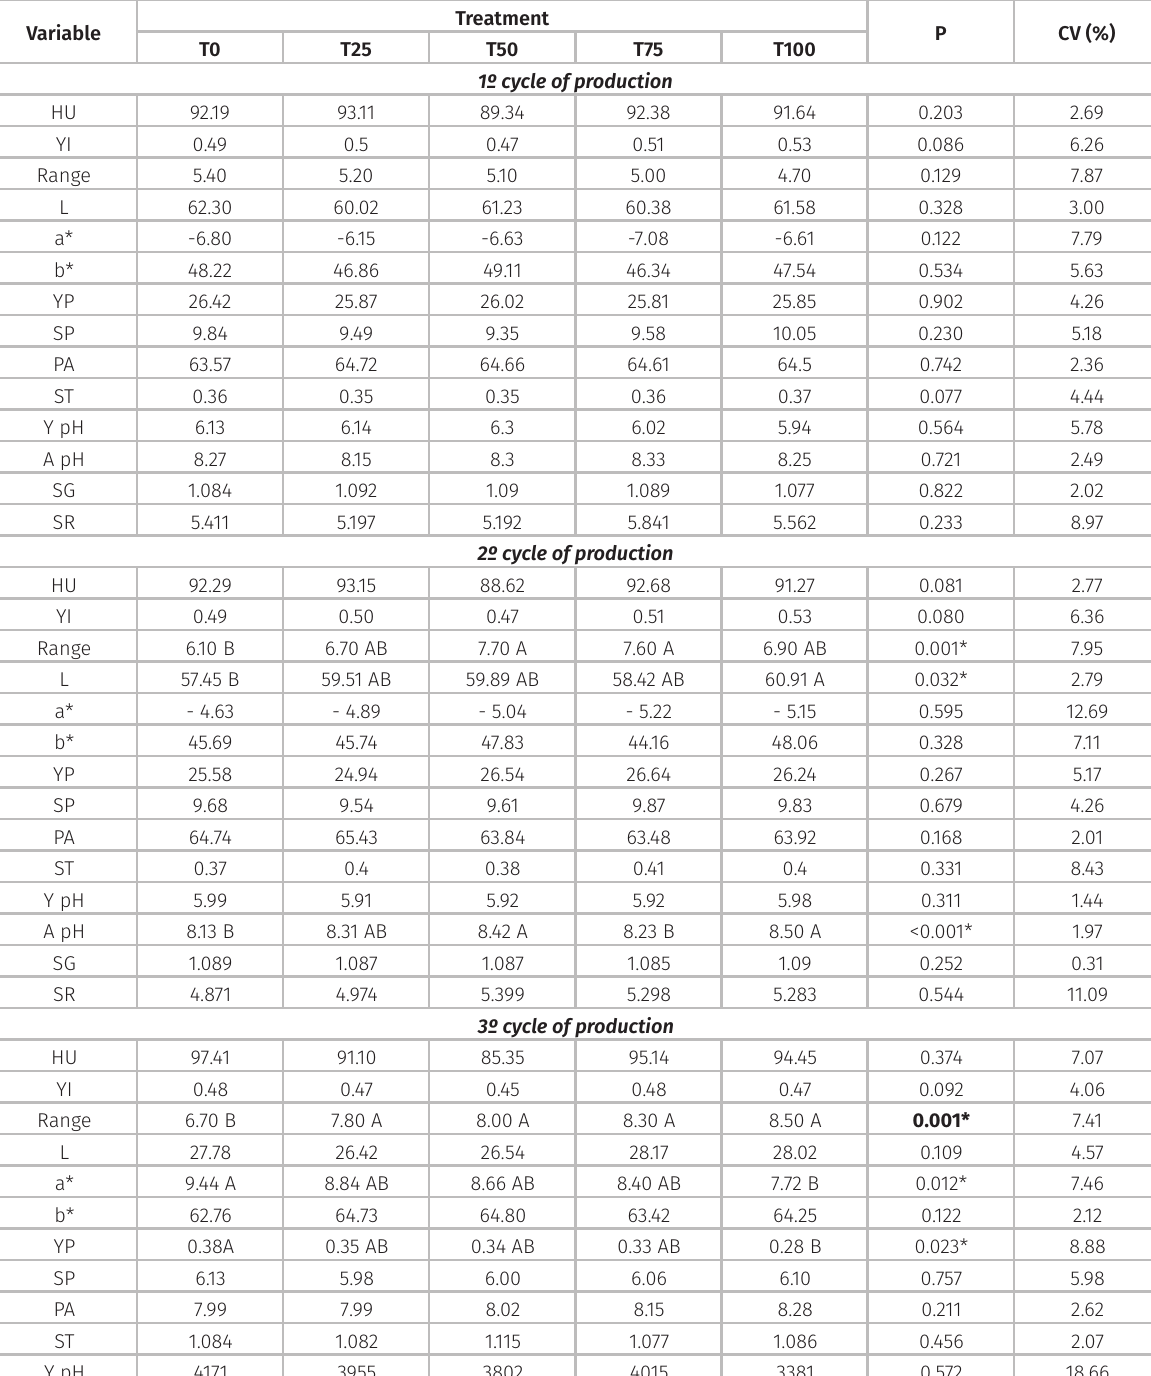
Table VI. Egg quality: Haugh units (HU), Yolk index (YI), yolk coloring using the colorimetric DSM range (range), luminosity (L), yellow intensity (a*), yellow intensity (b*), yolk percentage (YP), Shell percentage (SP), albumen percentage (PA), shell thickness (ST, mm), yolk pH (Y pH), albumen pH (A pH), specific gravity (SG) and shell resistance (SR, Kgf) of eggs from the first, second and third production